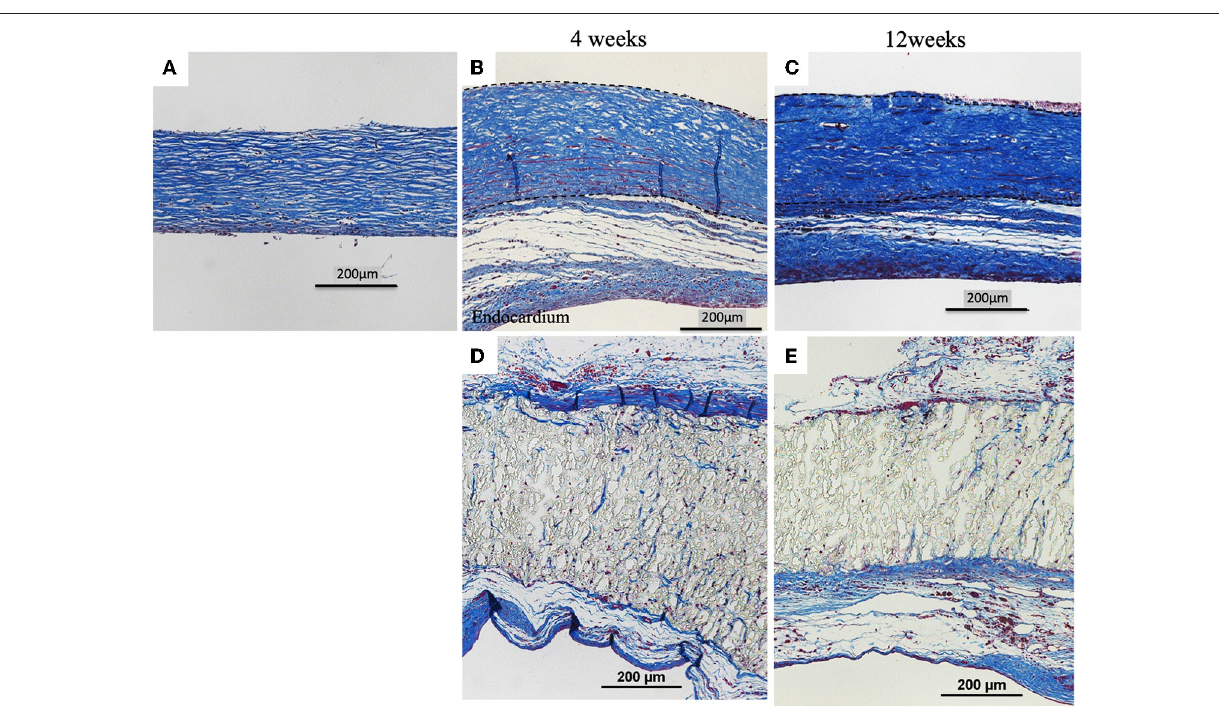
Frontiers in Veterinary Science | www.frontiersin.org